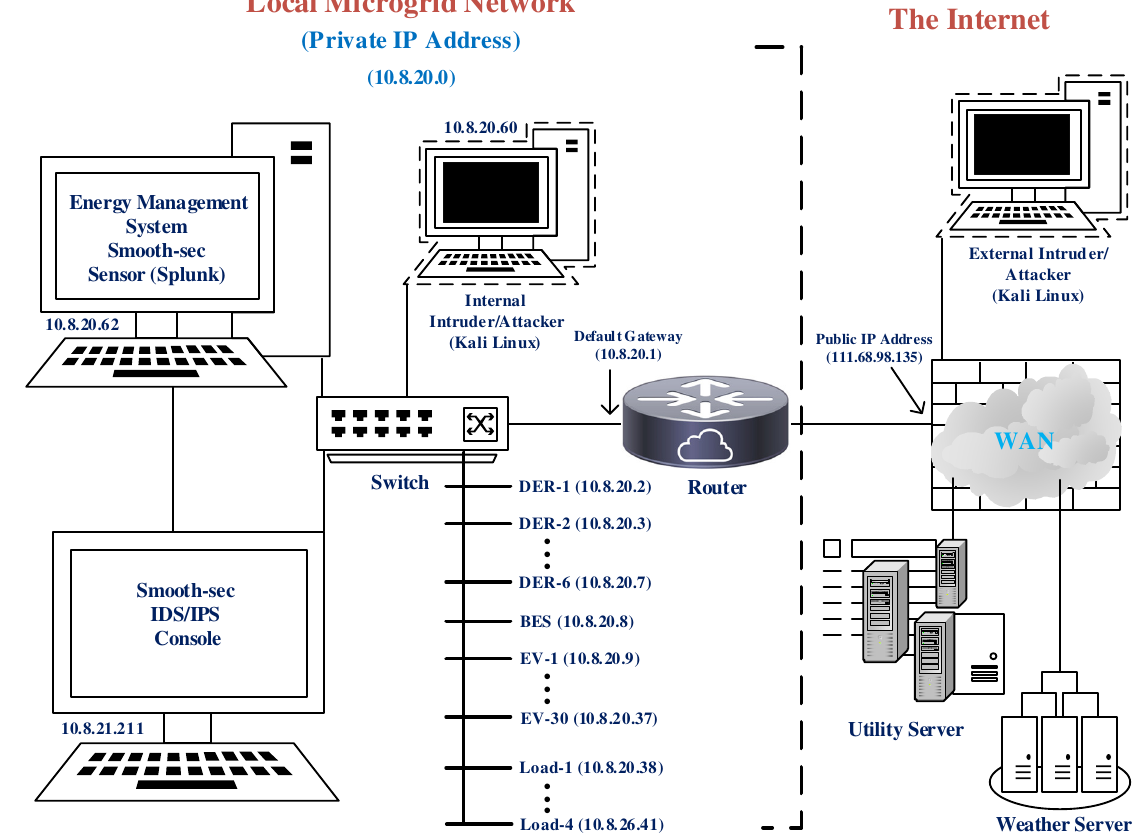
Fig. 9: Proposed industrial microgrid network topology